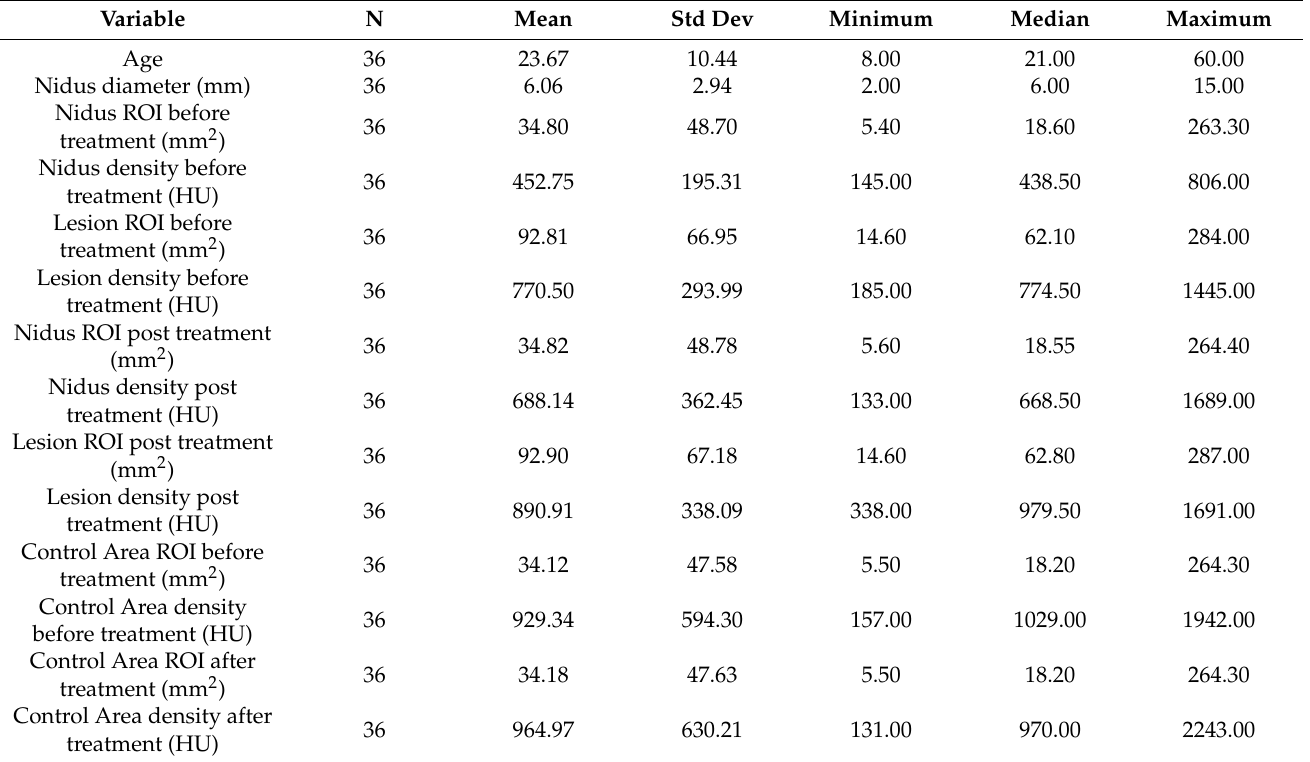
Figure 4. Bone density values at lesion level (LR) before and after MRgFUS treatment (770.50 ± 293.99 HU and 890.91 ± 338.09 HU, respectively, treatment*time interaction p = 0.010, estimated with two-factor ANOVA with repeated measures on one factor, CI = 95%). Y axis: bone density; L: Lesion ROI; C: control ROI. Table 1. Population and Imaging